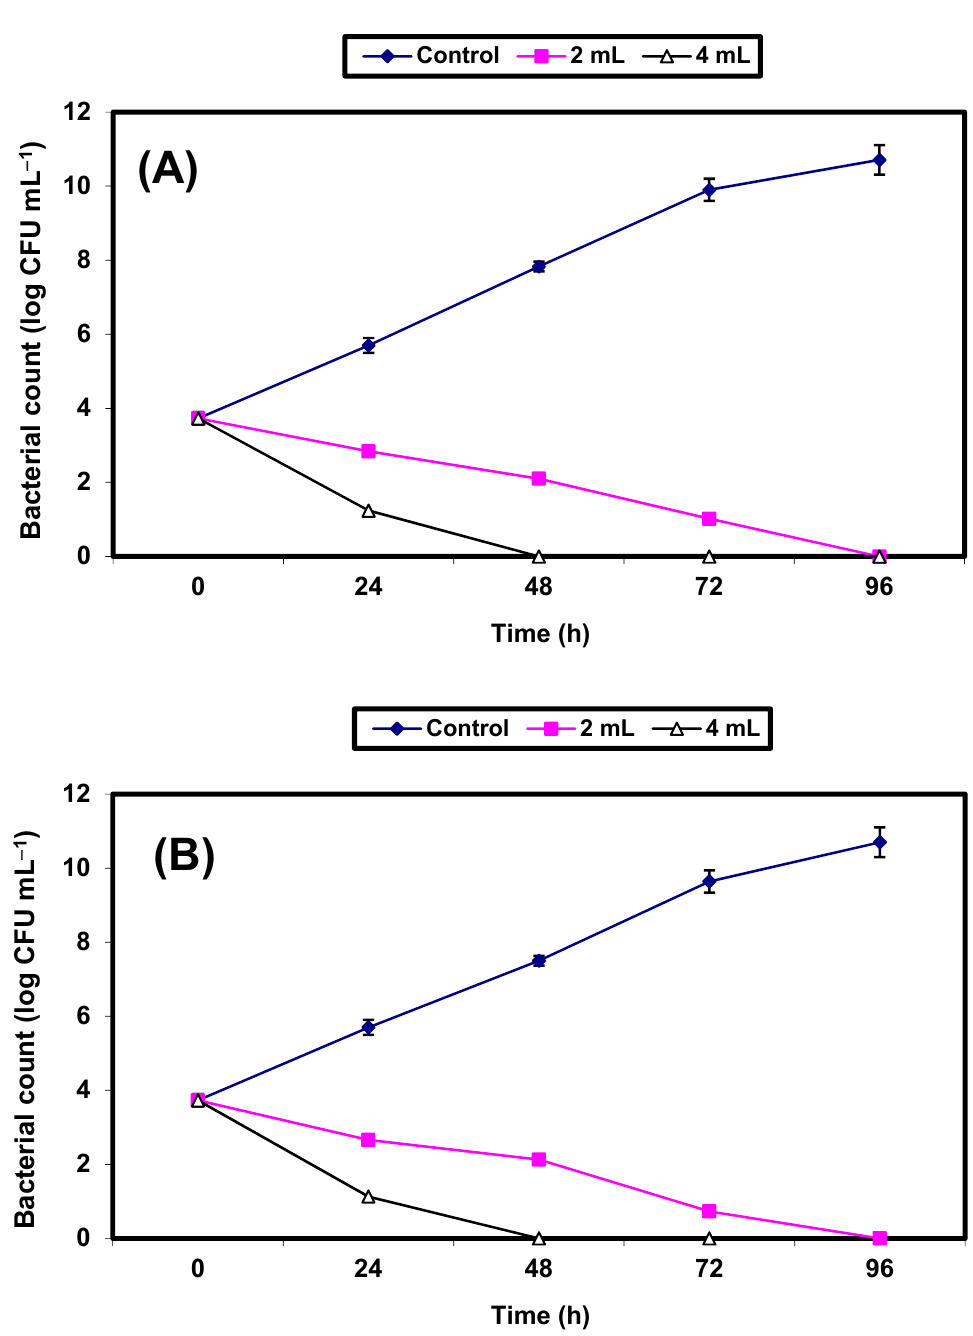
Figure 7. Inhibition of both S. aureus ( A ) and E. coli ( B ) in tomato juice. Symbols ♦ , ■ , ∆ refer to untreated control samples and juice samples treated with 2% and 4% KFB, respectively.